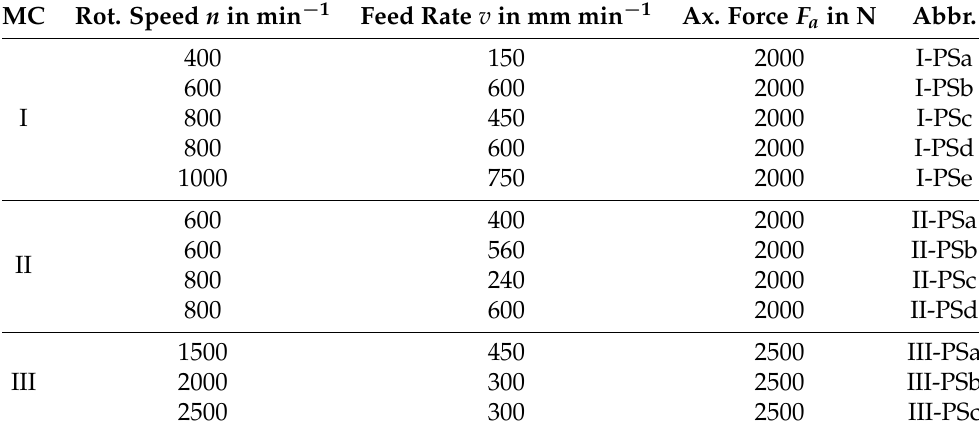
Table 4. Parameter sets for the FPJ experiments for each material combination and their used abbreviation (abbr.); all experiments were conducted with a tilt angle α of